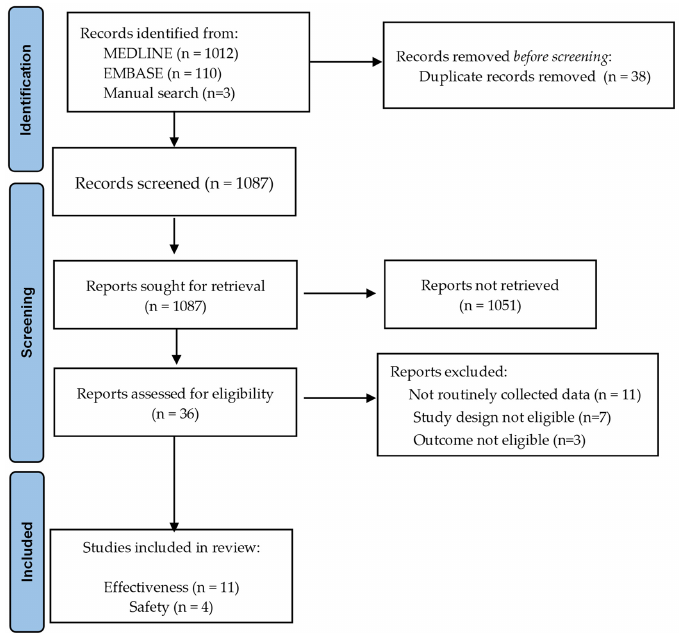
Figure 1. Studies selection flowchart.